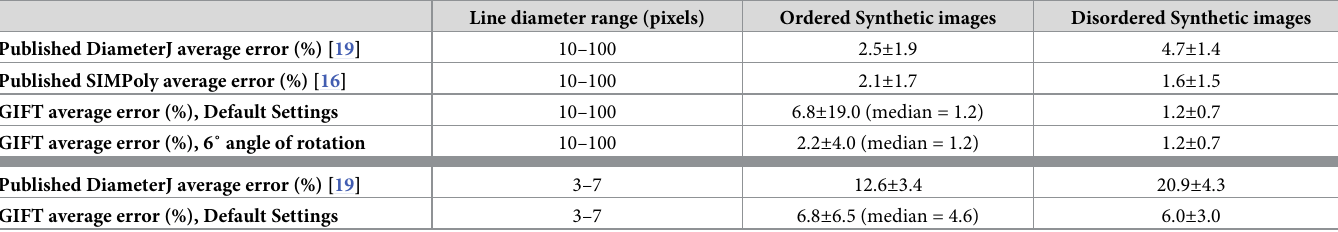
Table 1. Average percent errors based on analysis of synthetic image set with line widths between 3 and 100